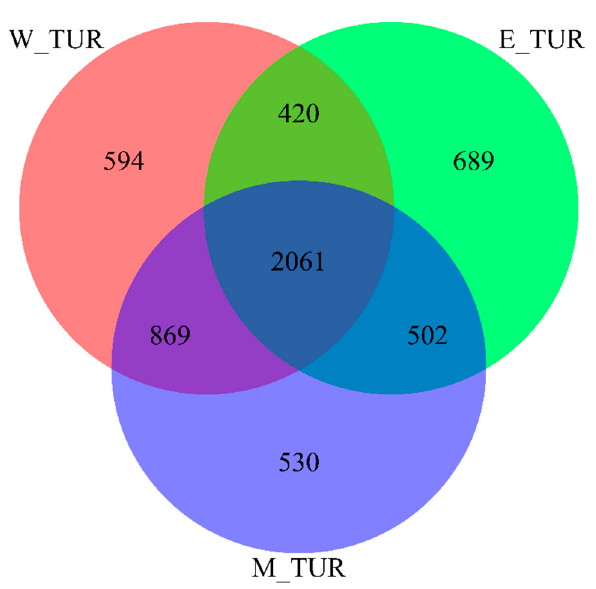
Figure 4. Venn diagram representing the number of unique and shared polymorphic SNPs in the three